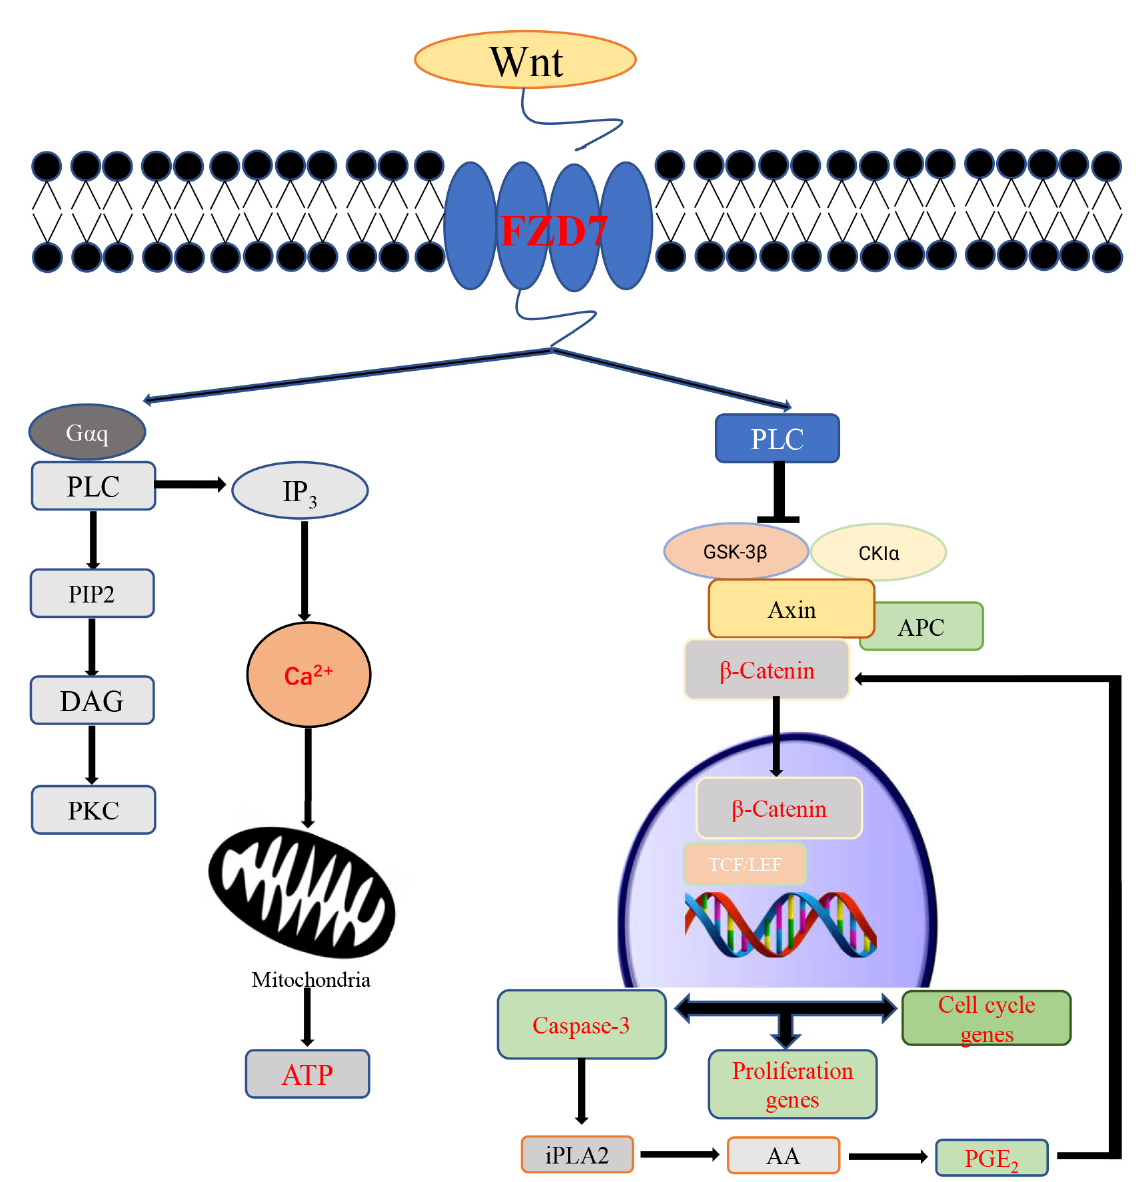
Figure 7. Model of the main investigations in this study.